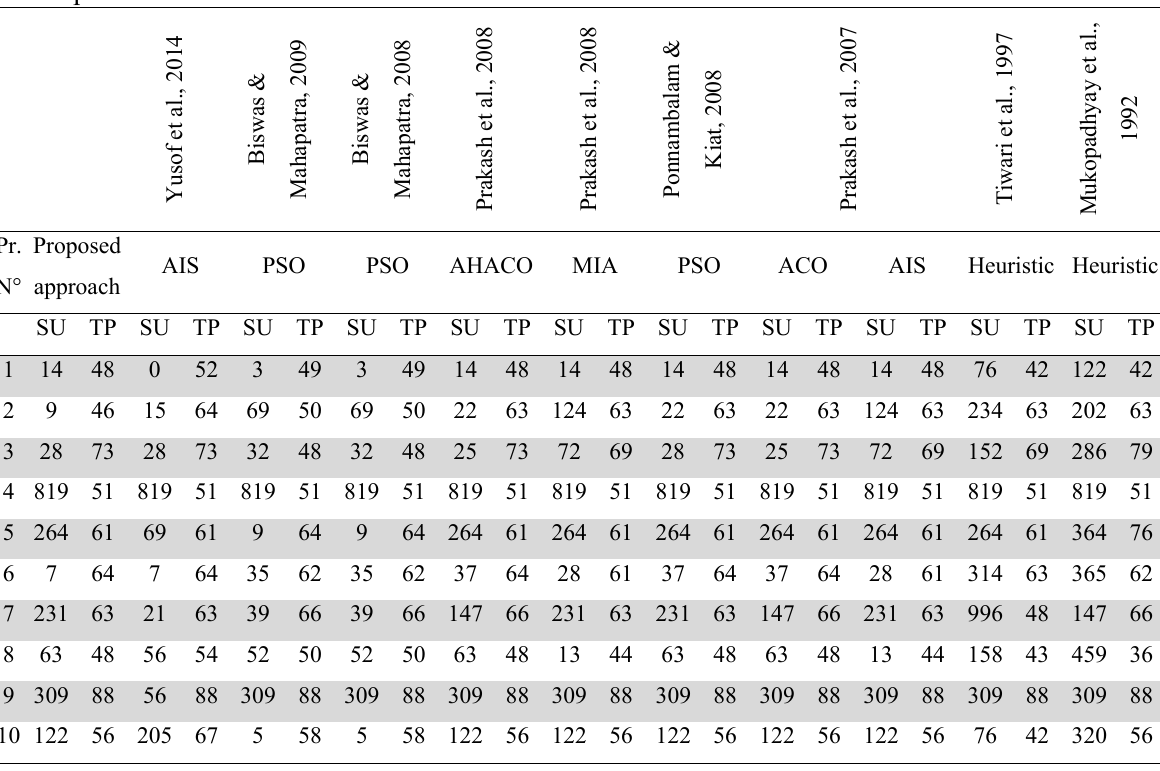
Comparison of the proposed modified DFA with other-heuristic solutions available in the open literature for the problem